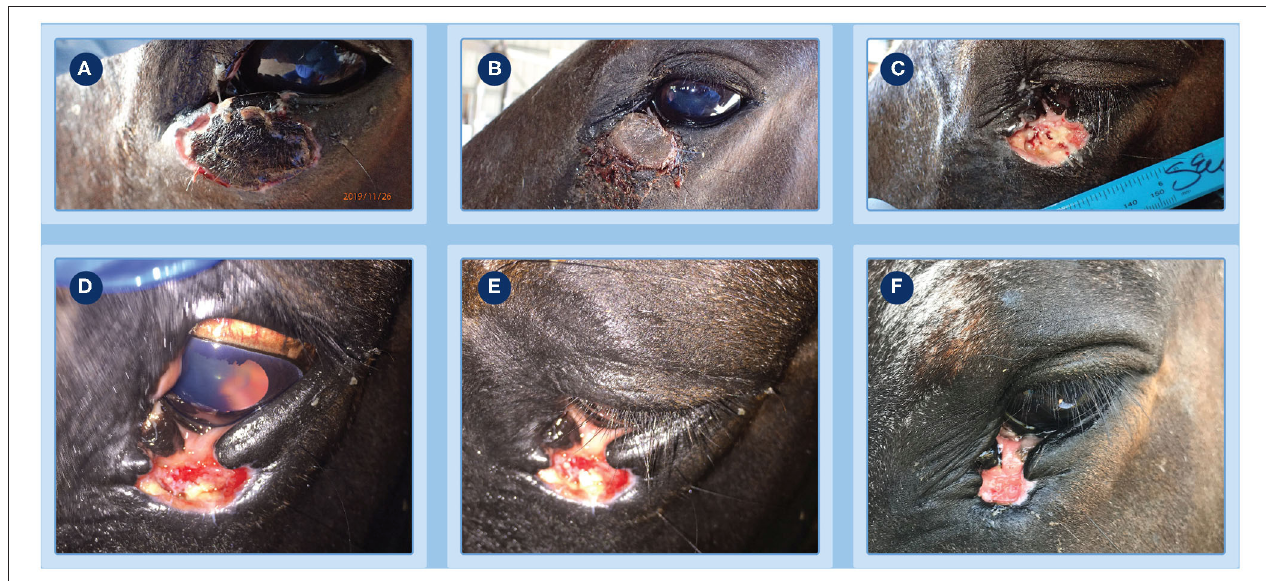
FIGURE 3 | Progression of clinical response of a peri-ocular SCC to treatment with tigilanol tiglate. (A,B) clear demarcation of the necrotic tumor mass at days 8 and 16, respectively; (C) underlying wound bed exposed following slight manual pressure to the eschar at day 16; (D,E) examination of the eye at day 19 show it to be normal and unaffected with a well-dilated pupil; (F) healing at the site by day 27.